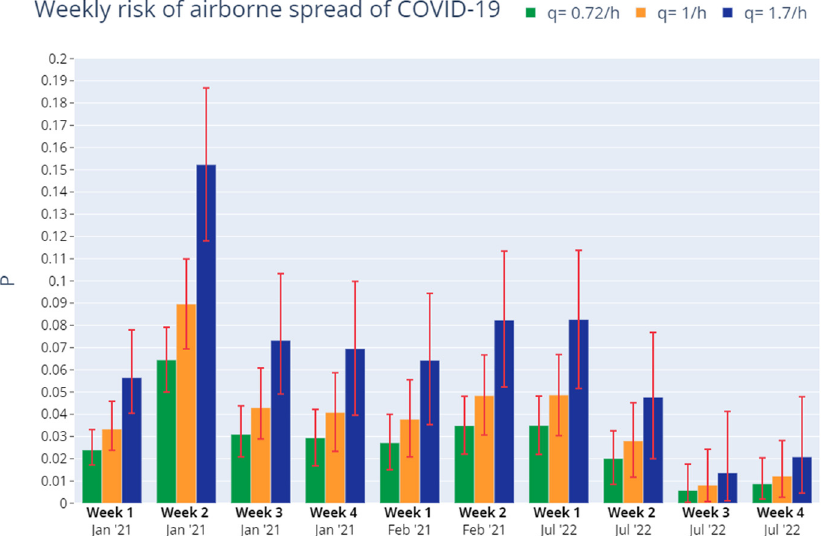
Figure 27. Weekly accumulated risk of secondary airborne spread of SARS-CoV-2 in the administra- tion space in Phases I, II and III. Source: authors.